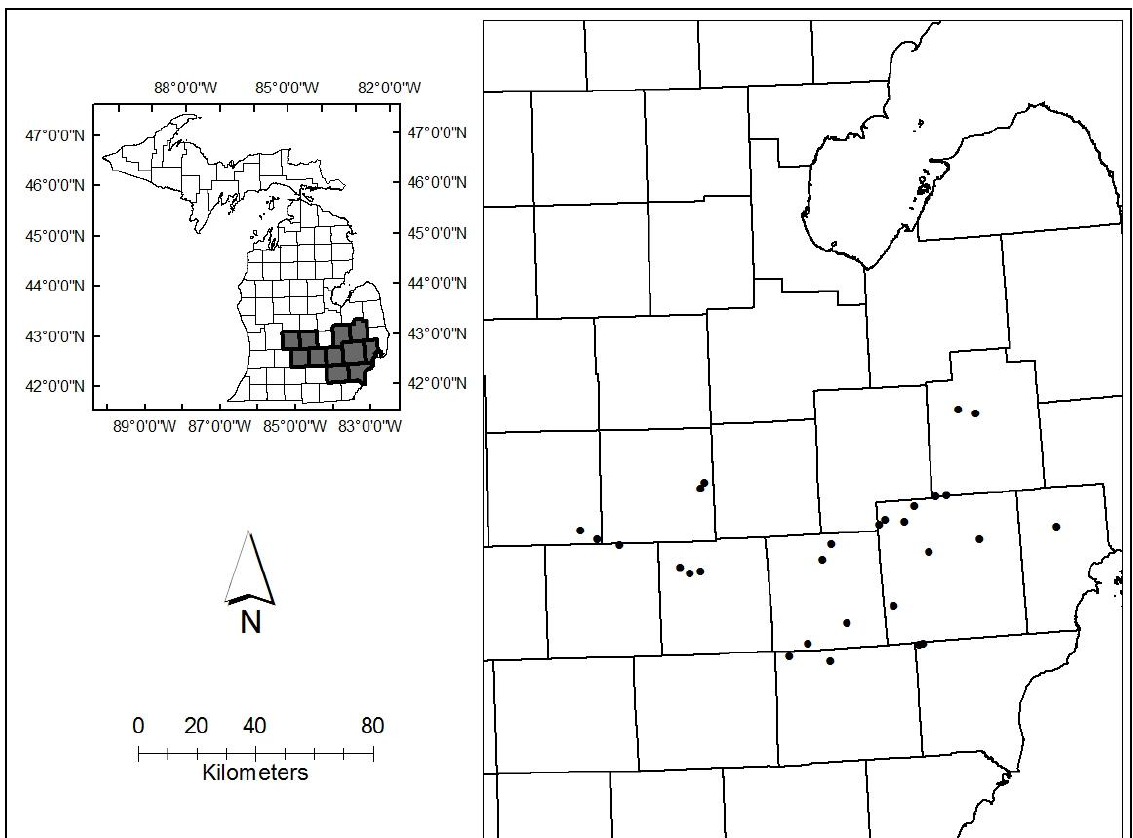
Figure 1. Distribution of 30 white ash sites in southeast and south central Lower Michigan.